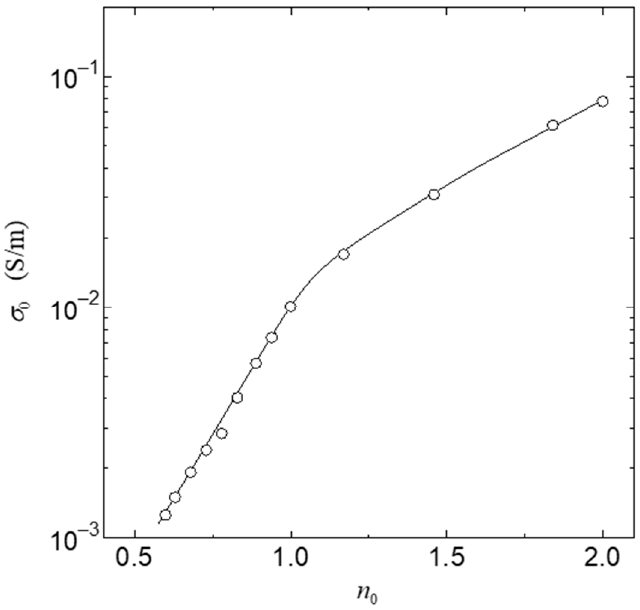
Figure 5. Relation between DC proton conductivity σ 0 and hydration number n 0 in the chitin film.